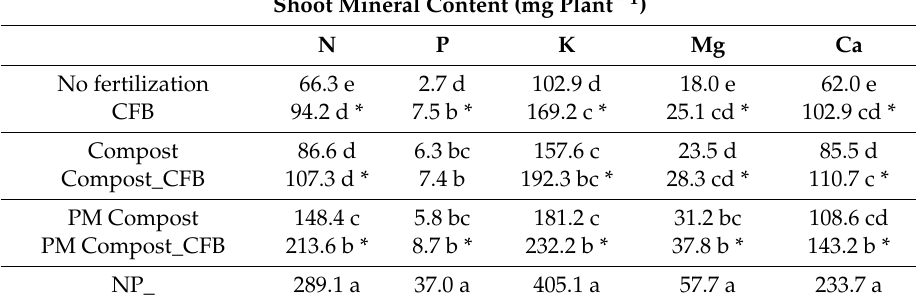
Table 2. Effects of Combifector B inoculation on the shoot accumulation of N, P, K, Mg, and Ca of 7-week-old tomatoes on pH 7.8 soil supplied with different fertilizers. (CFB = Combifector B, PM = Poultry Manure, NP = calcium nitrate plus superphosphate). Means and SE of five replicates. Significant treatment differences are indicated by different letters (T-grouping (LSD) at p = 0.05). * = significant difference compared with the non-inoculated control (NoBE) within the same fertilizer treatment ( t -test at p <